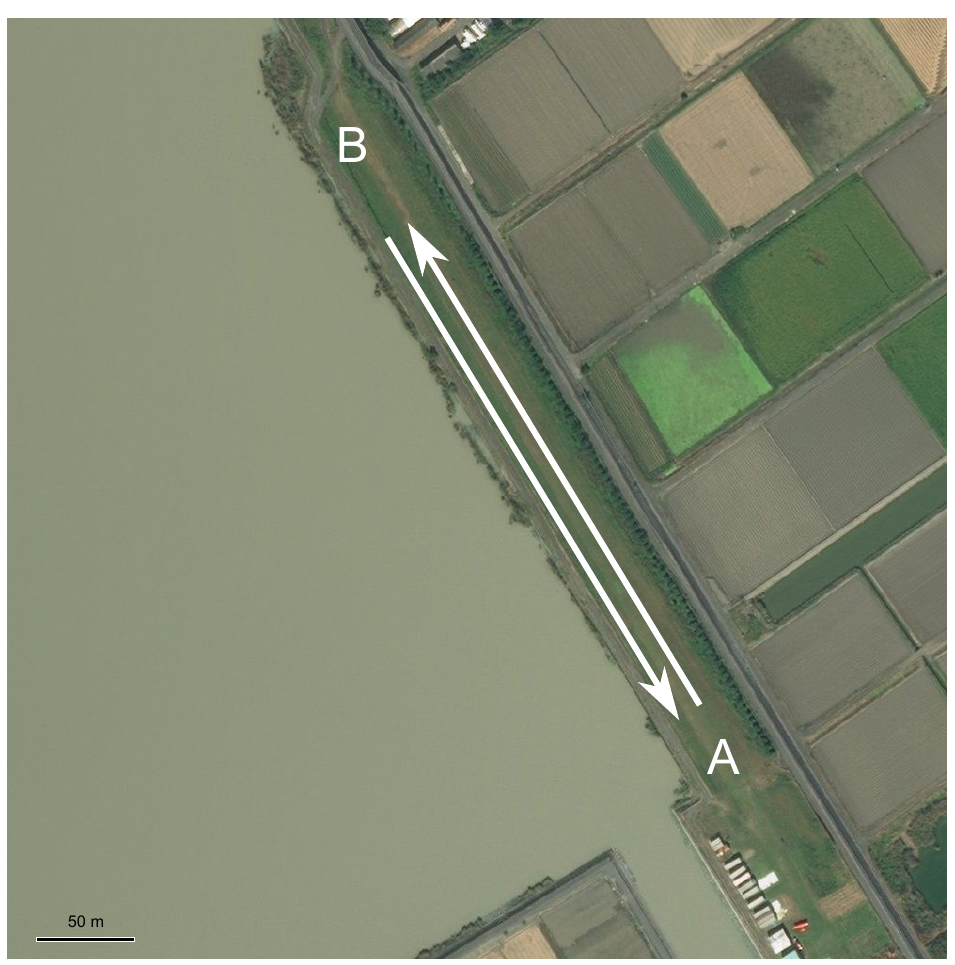
Figure 4. Aerial view of the run way used for the tow tests, at Shiroshi, Saga, Japan ( c (cid:13) DigitalGlobe, c (cid:13)